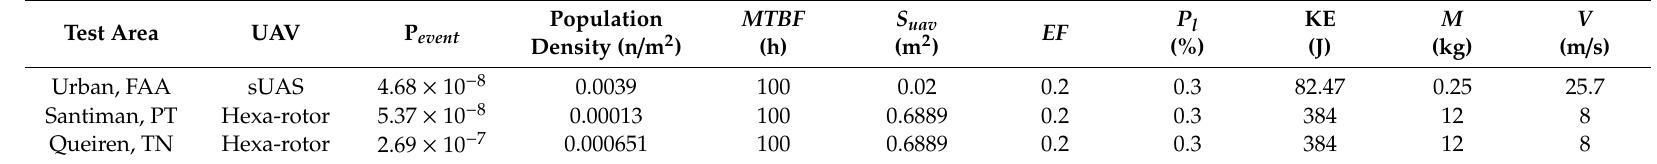
Table 1. Comparison of risk level for this study and using FAA data [1].